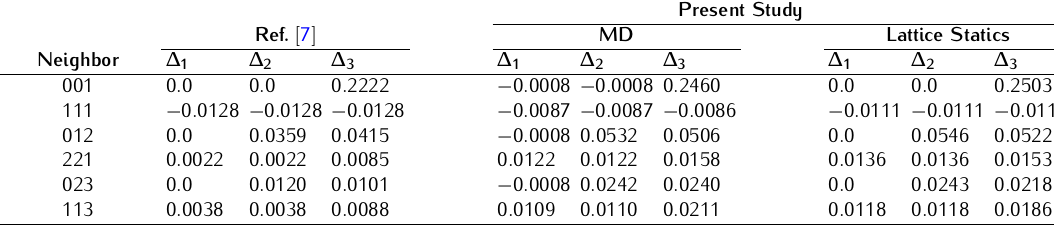
Table 2. The normalized displacement components of the atoms near the OSIA within the Cu host lattice. Present Study Ref. [7] MD